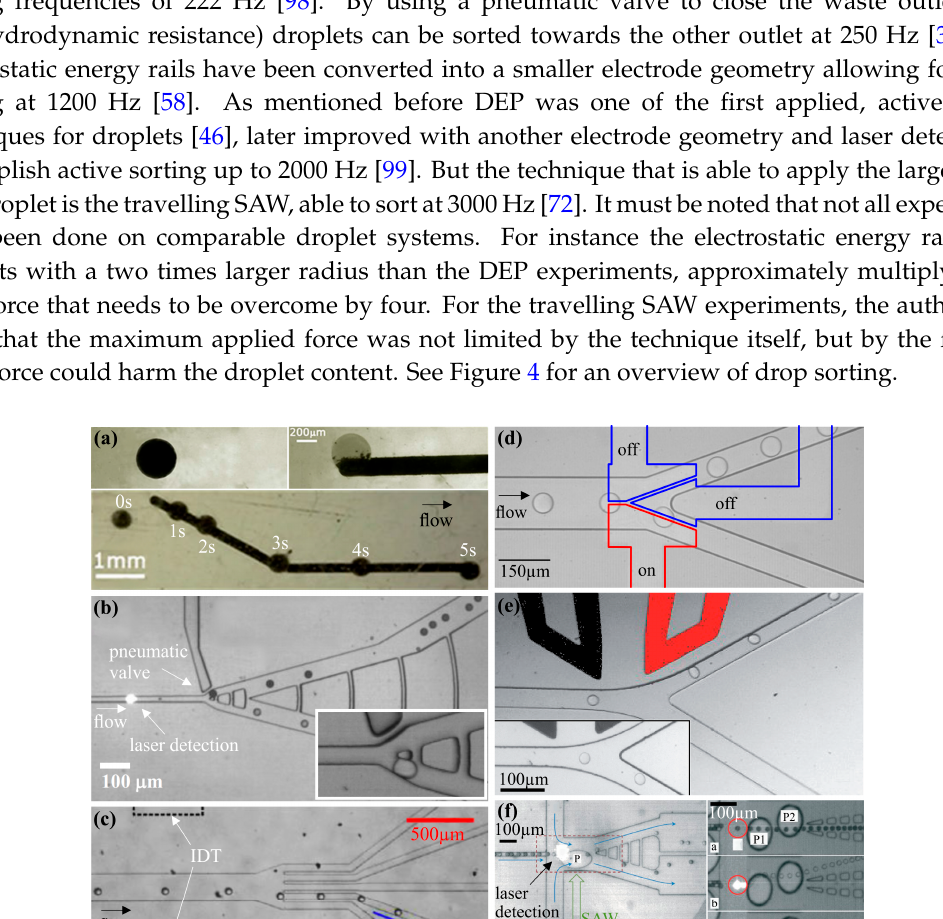
the electrode (red) an electric field gradient is created forcing water droplets to the upper channel. The Royal Society of Chemistry; ( f ) Left: The IDT generates a SAW, which is attenuated at the PDMS pillar. This locally creates a upwards pressure wave that forces a droplet to the upper channel. Right: Using two IDTs and two pillars allows to sort to multiple outlets. Adapted from [72] with permission of The Royal Society of